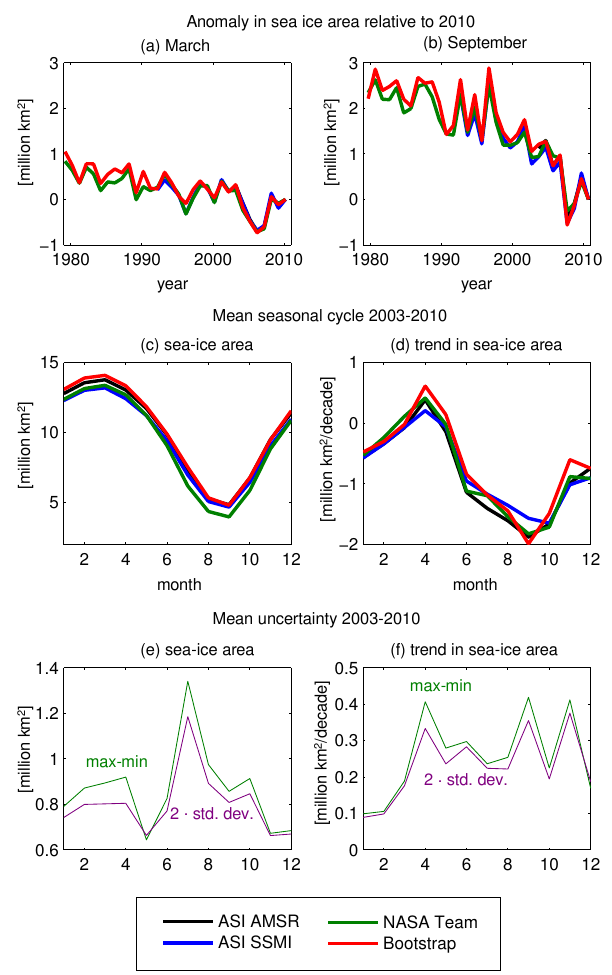
Fig. 12. (a) March and (b) September anomalies in sea-ice area as retrieved from satellites for the period 1979–2010. Different colours denote different algorithms or satellites. (c) Seasonal cycle in sea- ice area and (d) in sea-ice-area trend as retrieved from satellites for the period 2003–2010. (e) Uncertainty in retrieved sea-ice area and (f) in retrieved trend of sea-ice